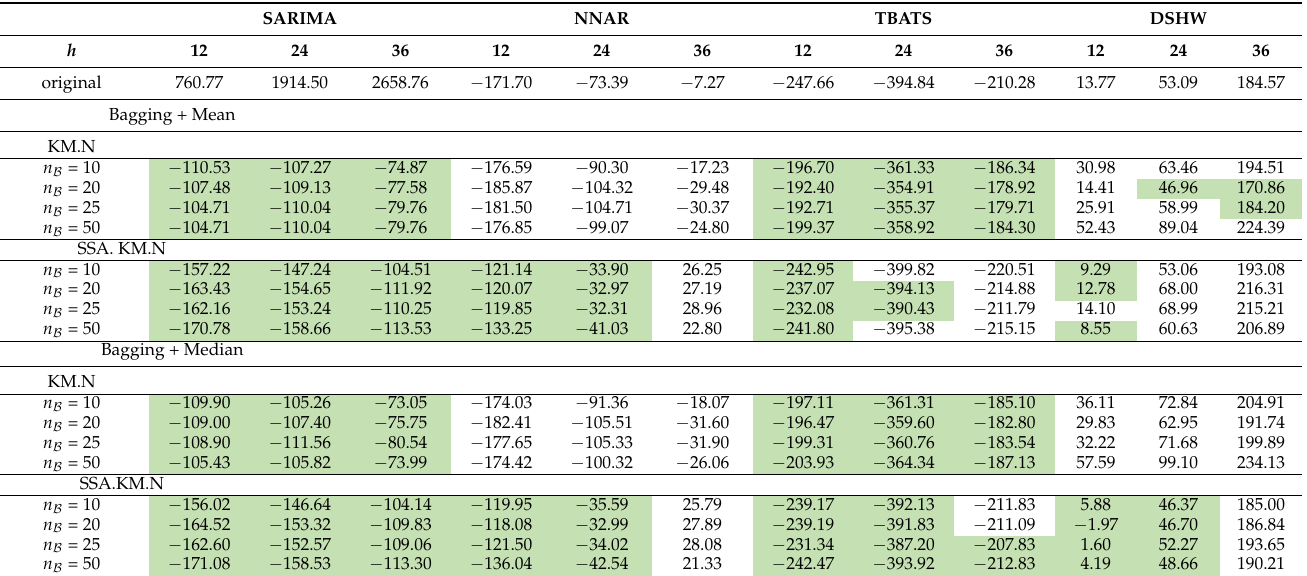
Table 14. MBE of h -step ahead forecast for the hourly electricity load of Indonesia obtained by SARIMA, NNAR, TBATS, and DSHW